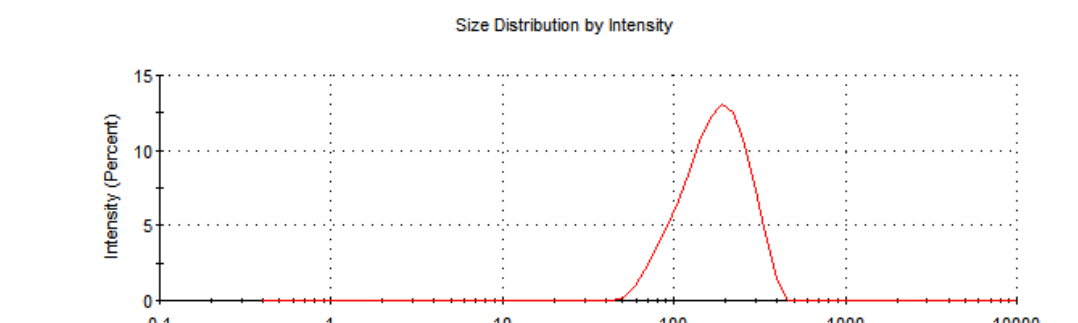
Figure 2. Z ‐ Average and Size distribution of green TiO 2 nanoparticles.